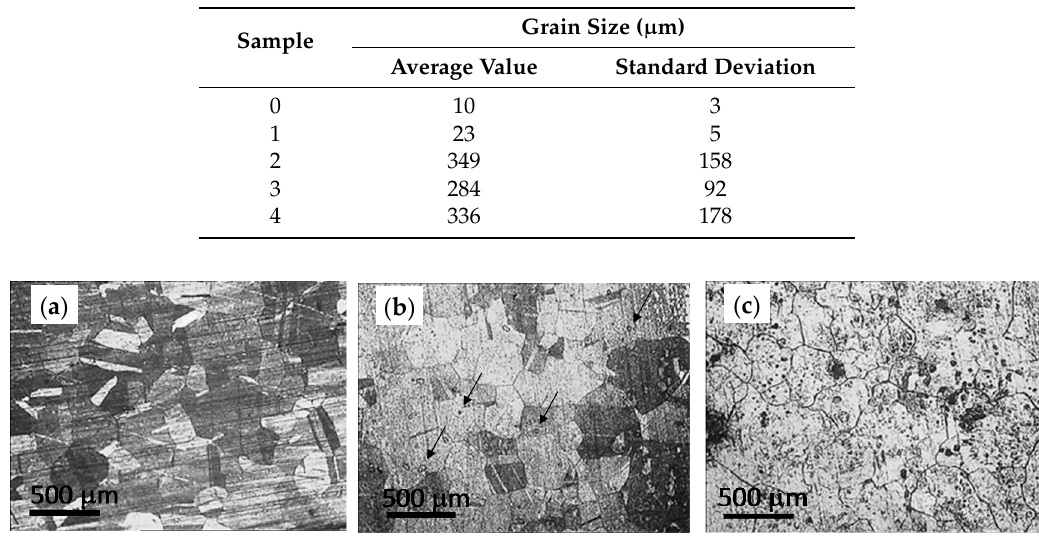
Figure 2. Optical micrographs of: ( a ) chemically etched sample 2; ( b ) chemically etched sample 3; and ( c ) chemically etched sample 4.